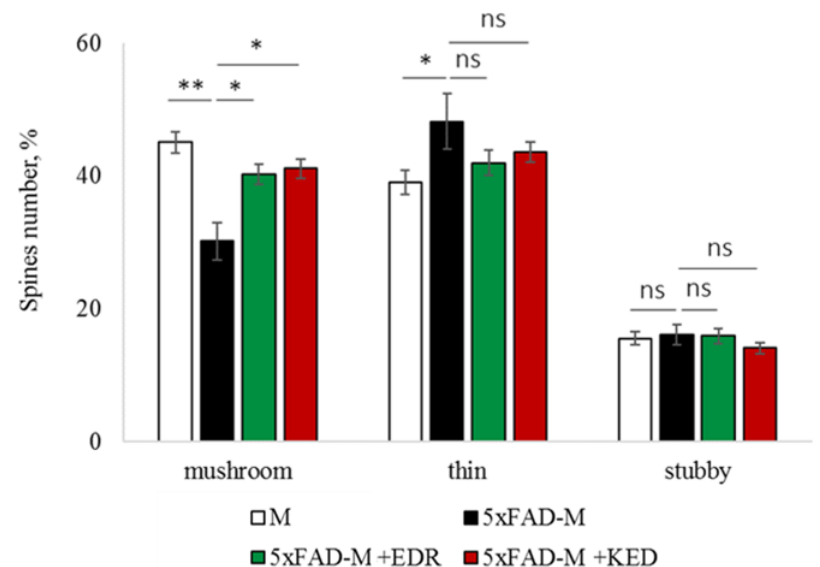
Figure 6. Spine density of CA1 secondary dendrites in 5 month-old male M-line and 5xFAD-M mice, injected with physiological solution, EDR peptide, KED peptide. *, **, ***— p < 0.05, p < 0.01, p < 0.001 compared to the 5xFAD-M mice injected with physiological solution, ns—non-significant.